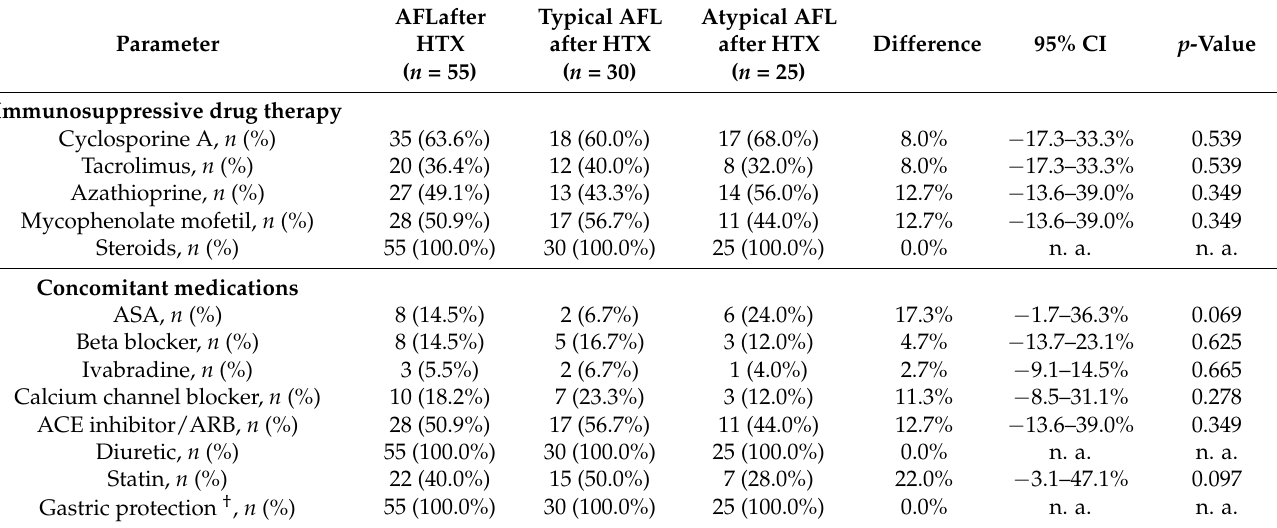
Table 4. Medications-stratified by typical and atypical late-onset AFL after